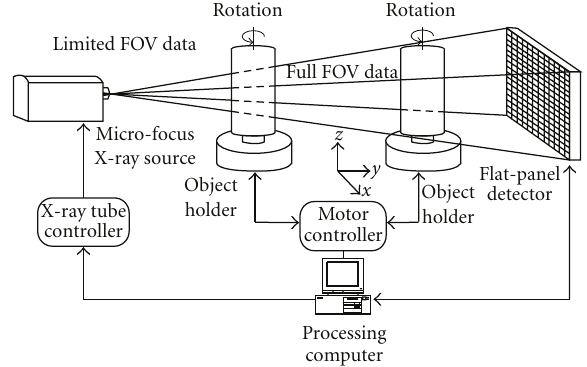
Figure 4: A schematic of a μ -CT system for acquisition of sinogram